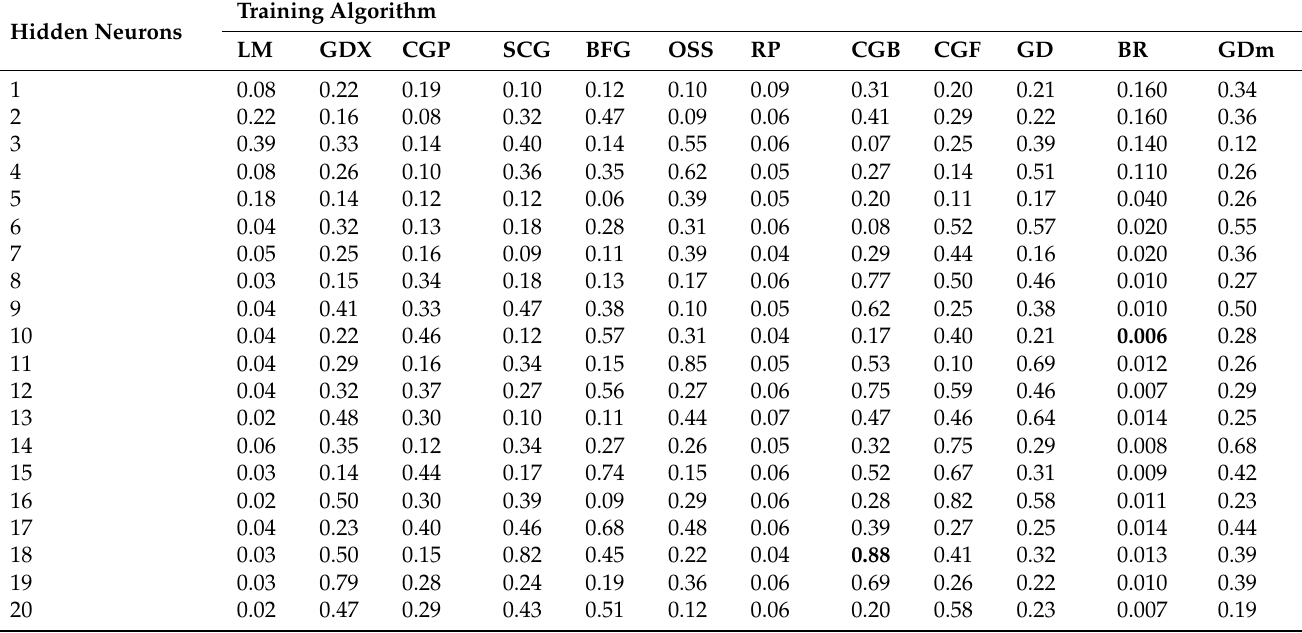
Table A17. MAPE methane yield for different training algorithms at different number of hidden neurons.